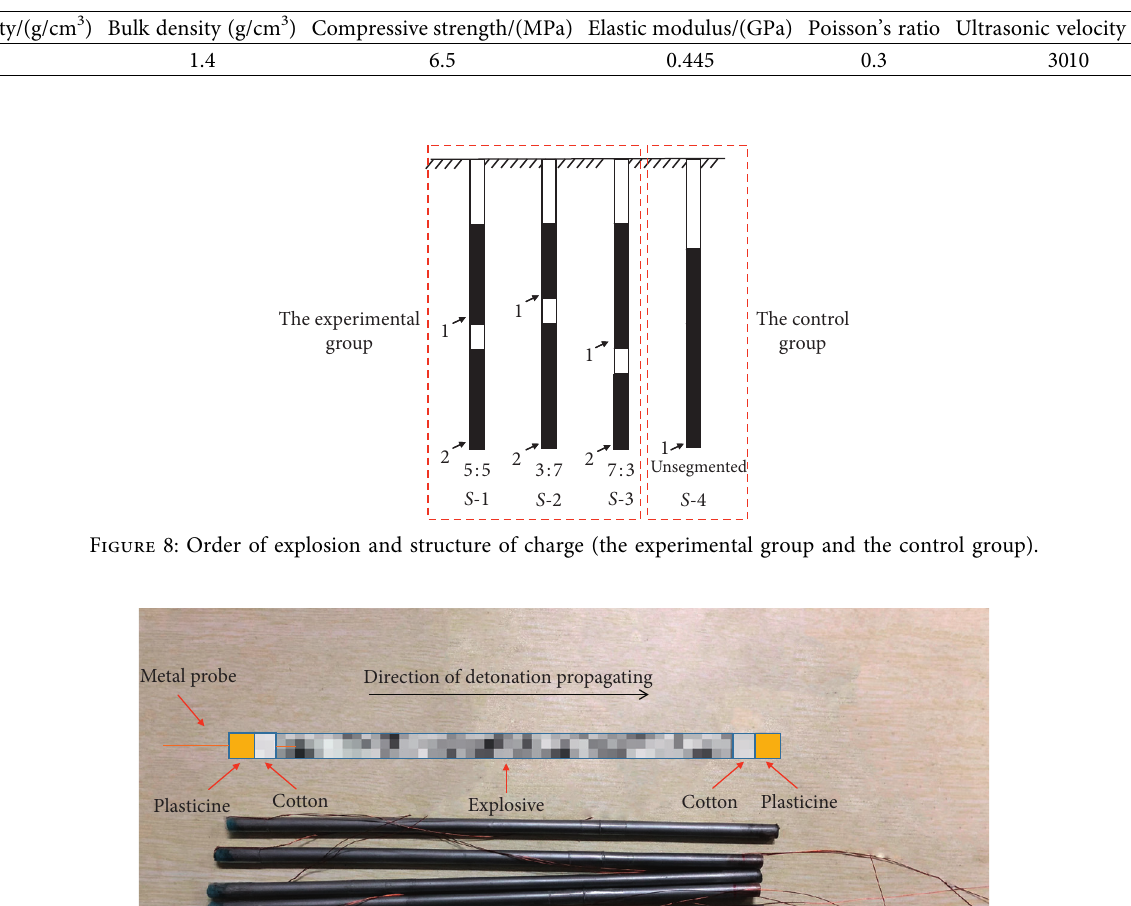
Figure 7: Parameters of the specimens and cutting area. Table 1: Measured physical and mechanical properties of gypsum.